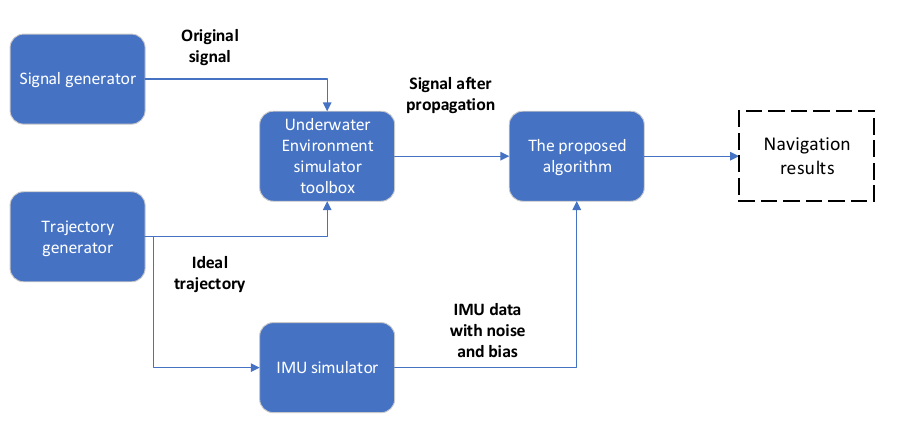
Figure 5. The block diagram of the simulation process.